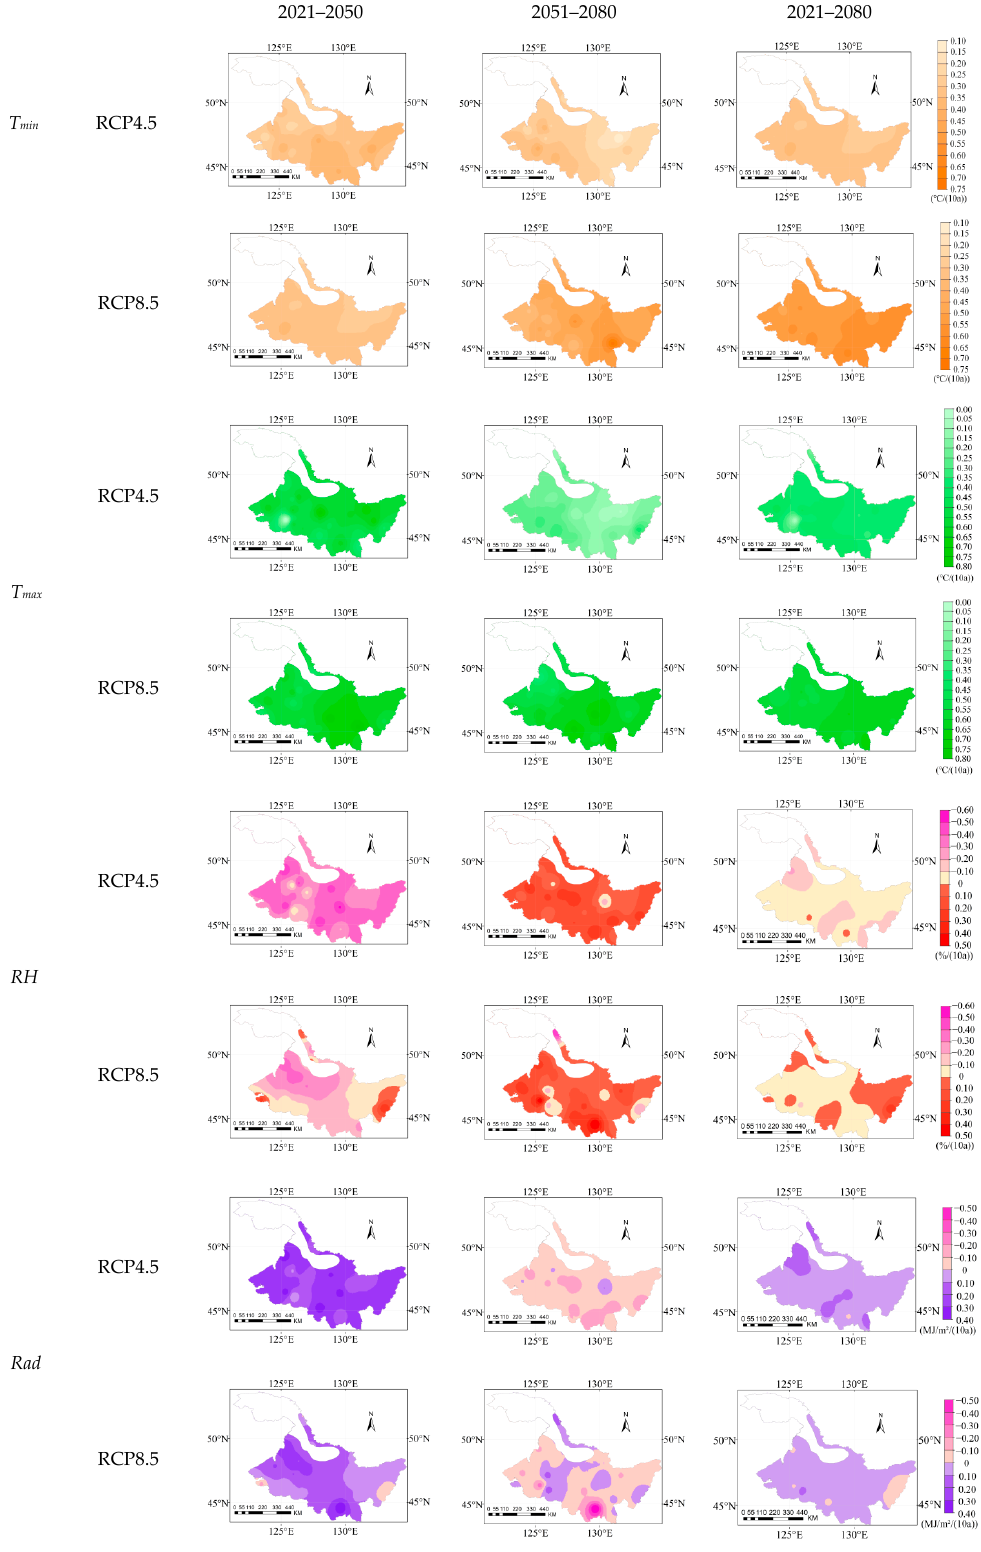
Figure 3. Climate tendency rates of average minimum temperature ( T min ), maximum temperature ( T max ), relative humidity ( RH ), and solar radiation ( Rad ) during soybean growth period under